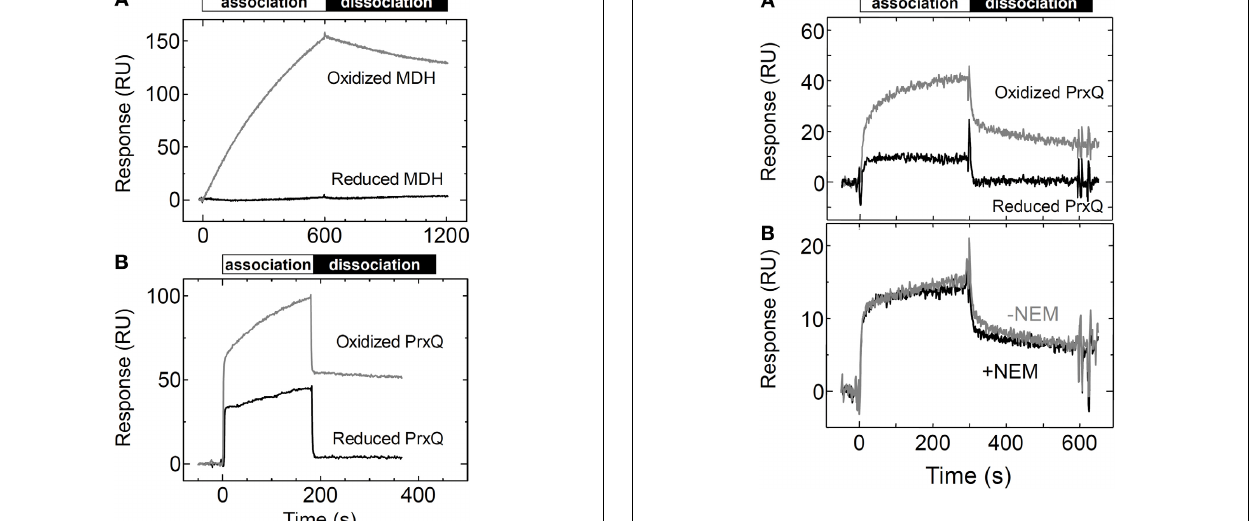
FIGURE 5 | Interactions between the Trx h 1 SS and the reduced and oxidized forms of PrxQ. (A) Reduced or oxidized PrxQ (5 μ M) was injected onto the Trx h 1 SS immobilized on a sensor chip and SPR signals were recorded. (B) The oxidized form of PrxQ (2 μ M) was injected onto Trx h 1 SS immobilized on a CM5 sensor chip before (gray line) and after (black line) thiol alkylation. Thiol alkylation was accomplished by injecting 10mM NEM for 10min onto the sensor